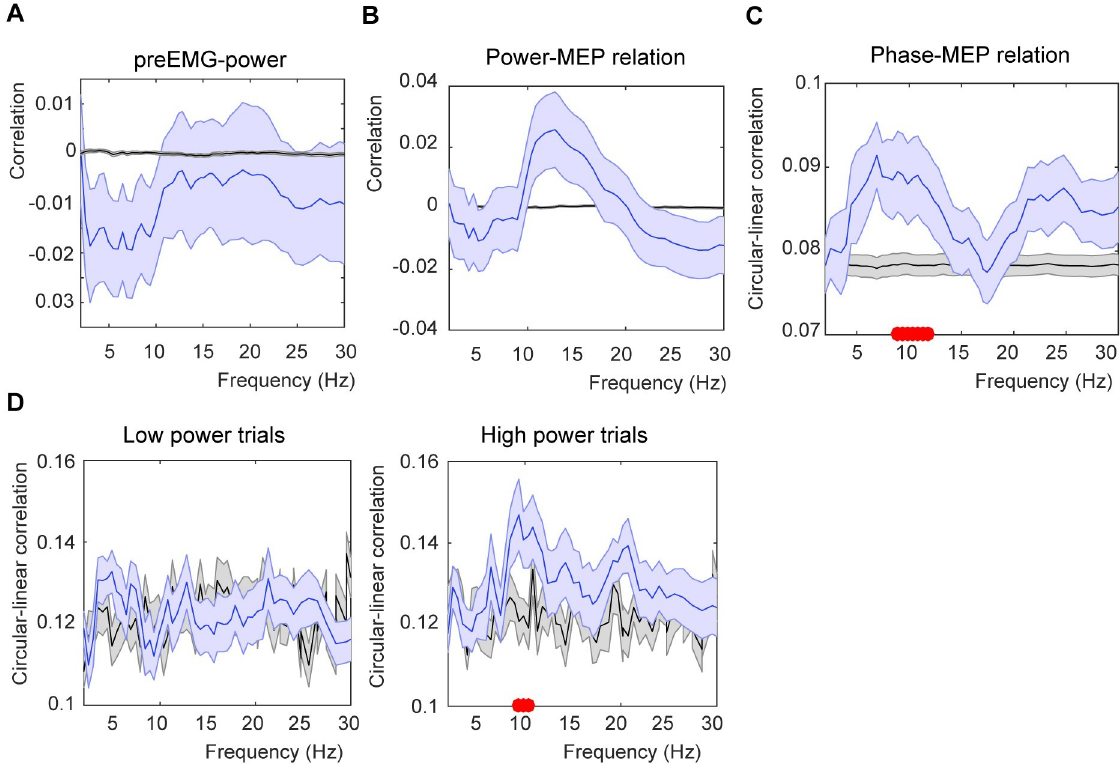
Fig 2. Analysis corrected for pre-TMS EMG activity and median split on power. A) Correlation between pre-TMS EMG activity and EEG power. B) Power-MEP size correlation using the residual power values (residuals of the correlation between power and pre-TMS EMG activity). C) Phase-MEP circular correlation using the residual MEP values (residuals of the correlation between pre-TMS EMG activity and MEP size). D) Phase-MEP circular correlation for either the low or high power trials. Conventions are the same as Fig 1.